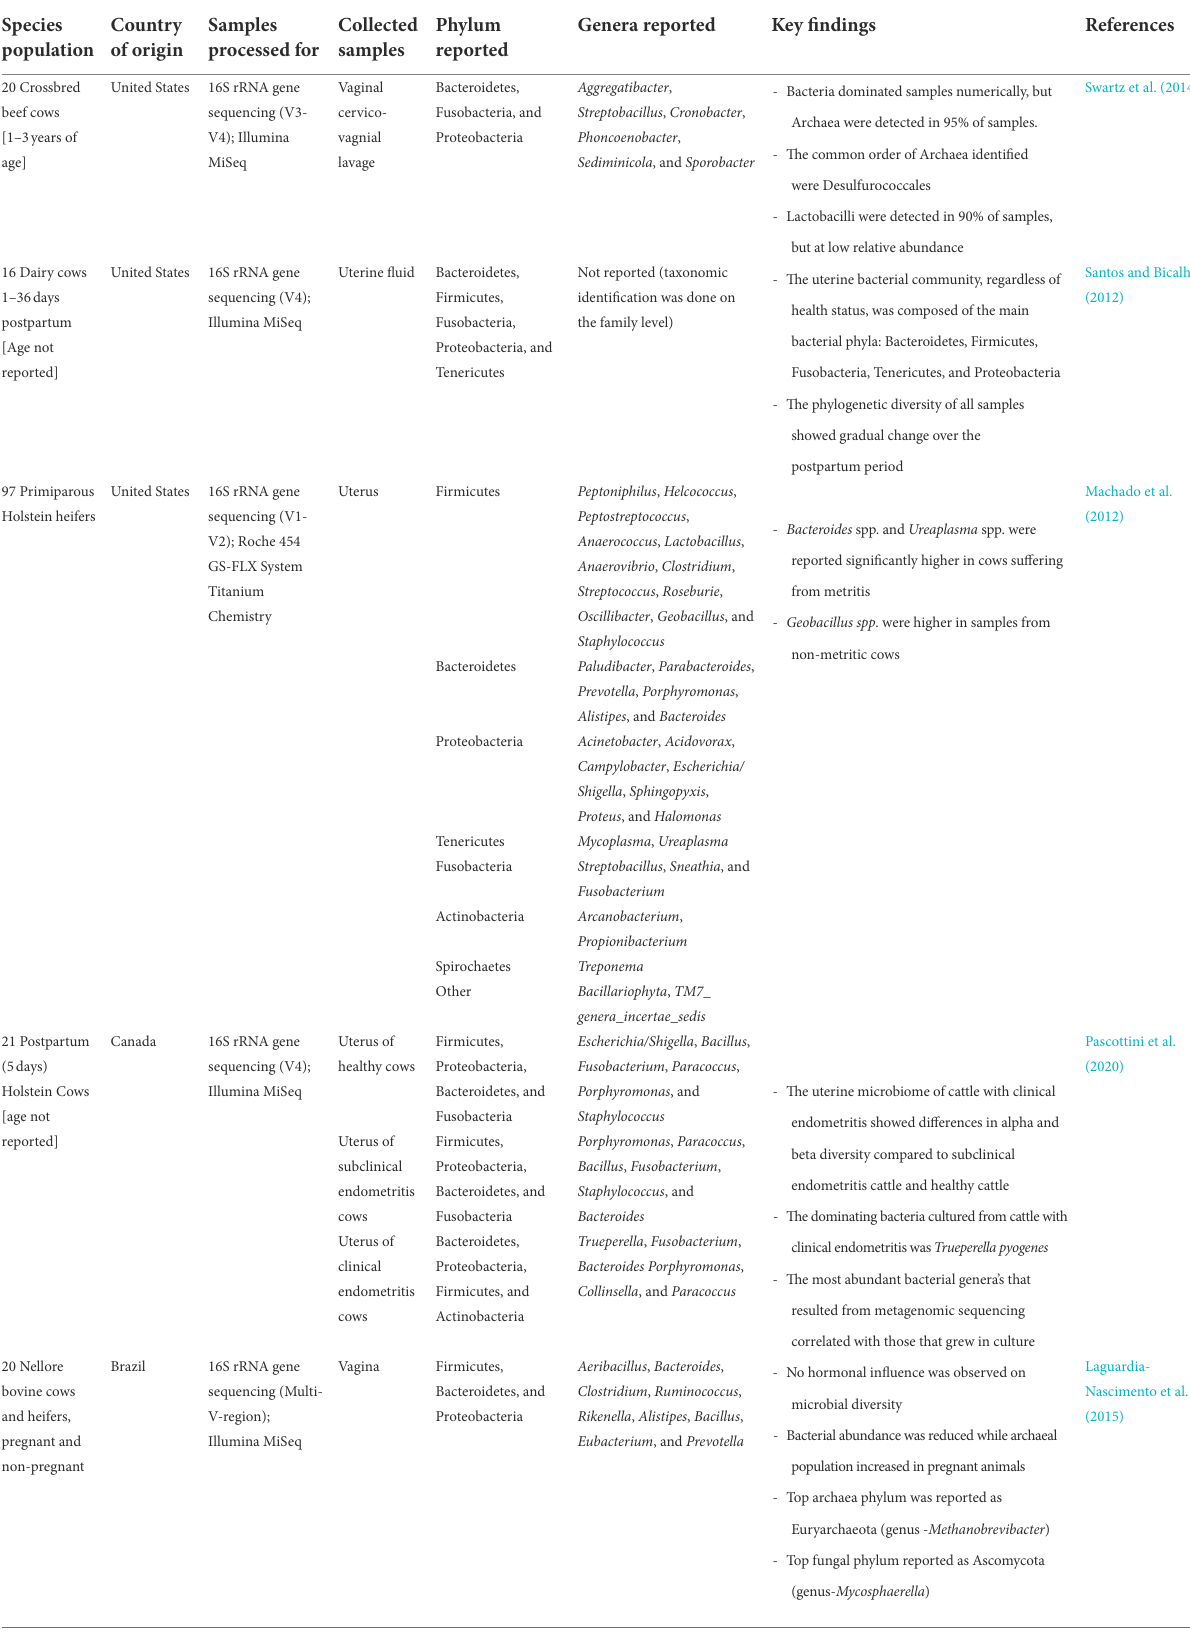
TABLE 2 Taxonomic identification of female reproductive tract microbiota from several recent high-throughput sequencing-based studies. Species Country Samples Collected population of origin processed for